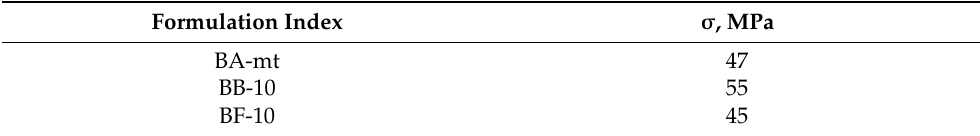
Table 6. Tensile strength of cured BA-mt, BB-10 and